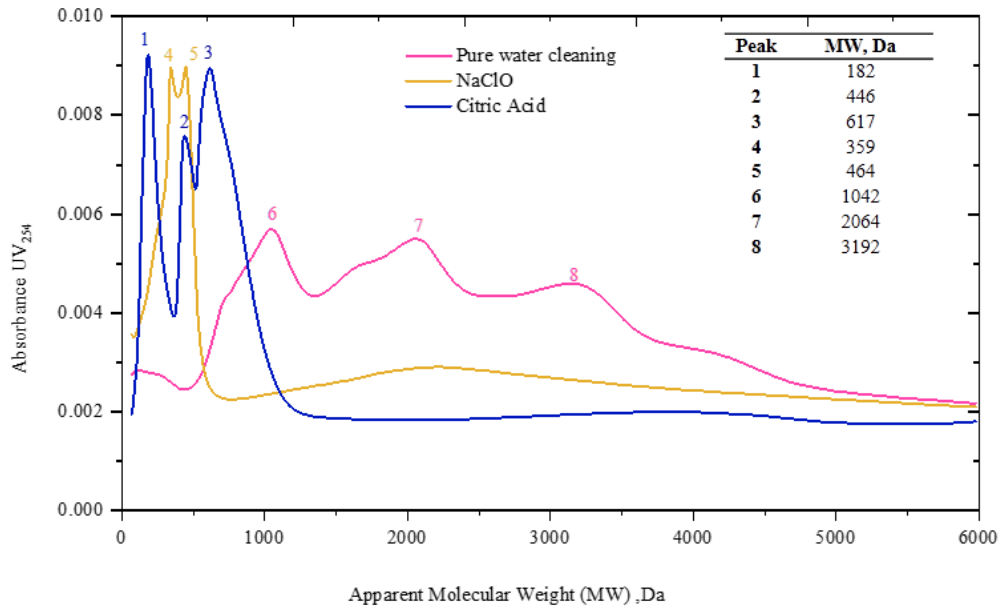
Figure 4. The apparent molecular weight distribution of cleaning solutions.